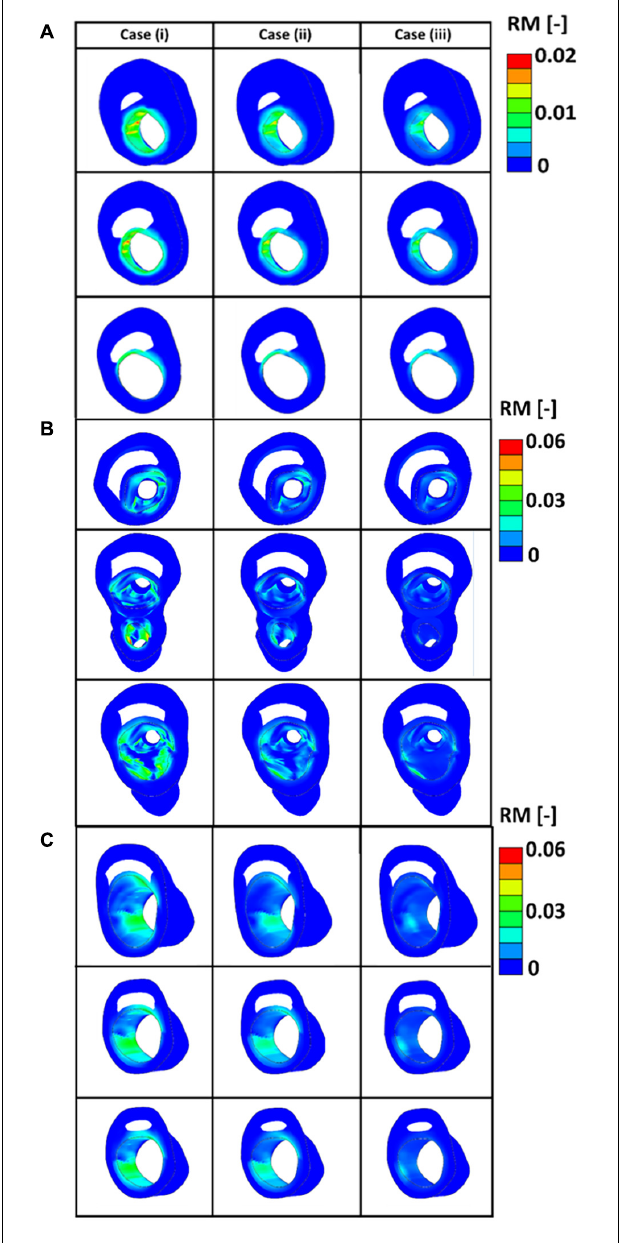
FIGURE 12 | (A) The values of the remodelling metric for the three different cases at cross sections of the diseased bifurcation corresponding to the first plane of Figure 9 . (B) The values of the remodelling metric for the three different cases at cross sections of the diseased bifurcation corresponding to the second plane of Figure 9 . (C) The values of the remodelling metric for the three different cases at cross sections of the diseased bifurcation corresponding to the third plane of Figure 9